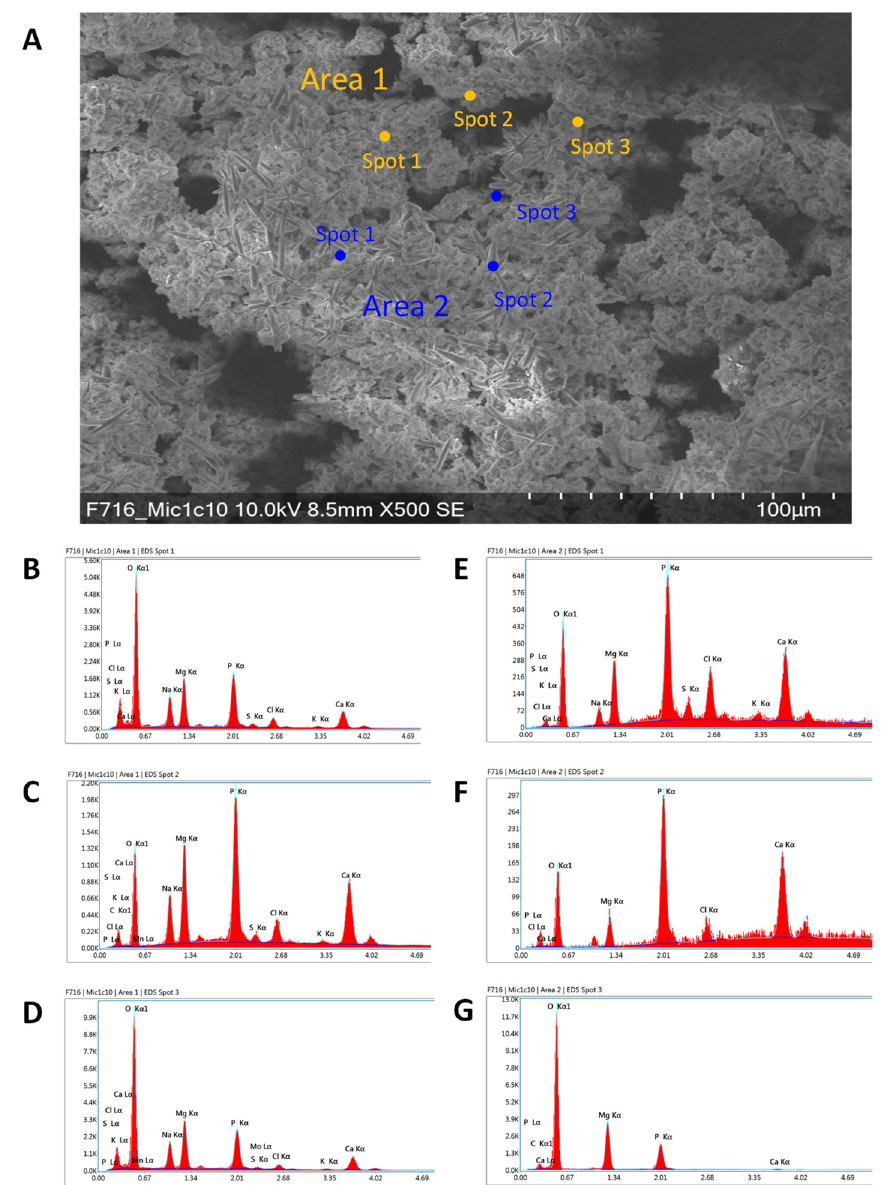
Figure 4. Element measurements at different spots of two areas of the electrode used during electromethanogenesis with M. maripaludis Mic1c10. ( A ) SEM picture of the electrode with deposits and distribution of the spots in areas 1 and 2. EDX analysis of ( B ) spot 1, ( C ) spot 2 and ( D ) spot 3 in area 1. EDX analysis of ( E ) spot 1, ( F ) spot 2 and ( G ) spot 3 of area 2. The x-axis shows the energy in